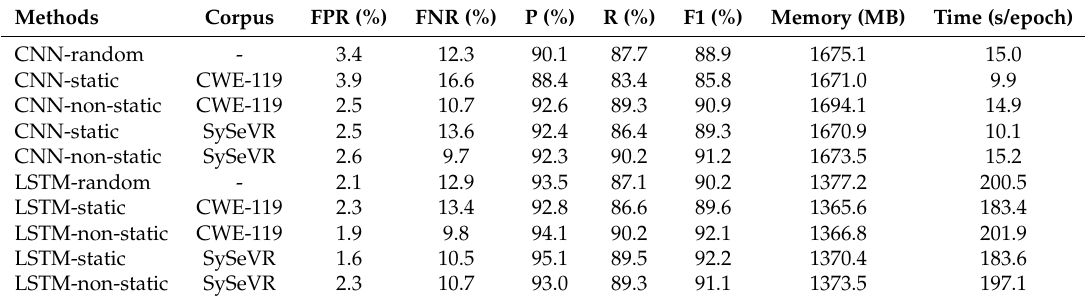
Table 4. Comparison of different embedding methods on different corpora. Memory, memory consumption; Time, time consumption.